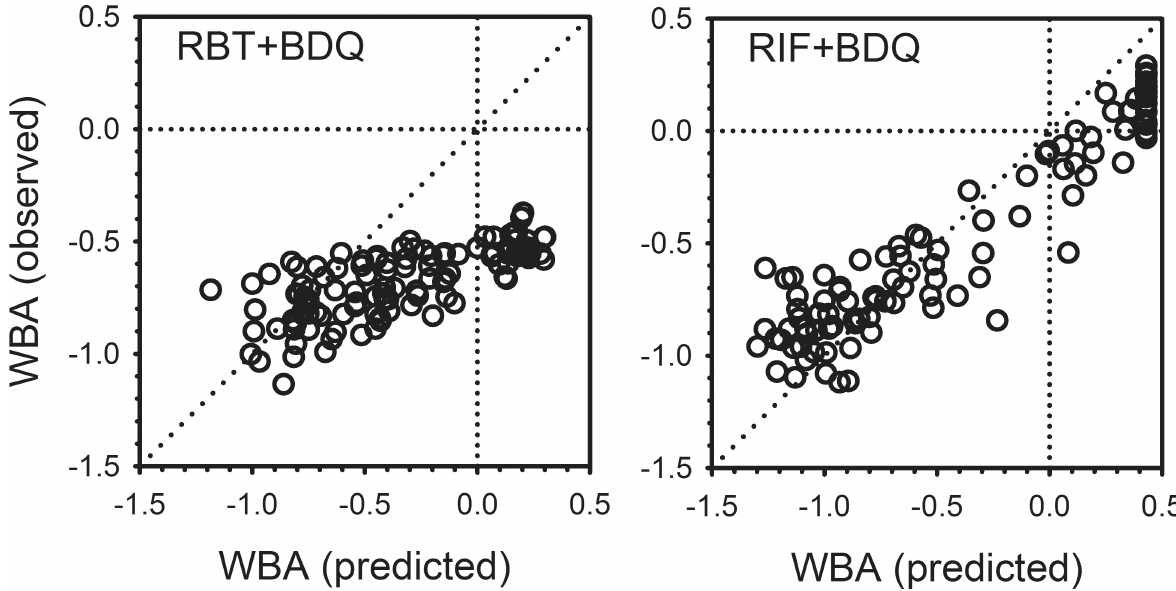
Fig 4. Whole blood bactericidal activity (WBA) observed for bedaquiline plus either rifabutin (left) or rifampin (right) in relation to that predicted as the sum of the activities of each drug alone, based on plasma concentrations.